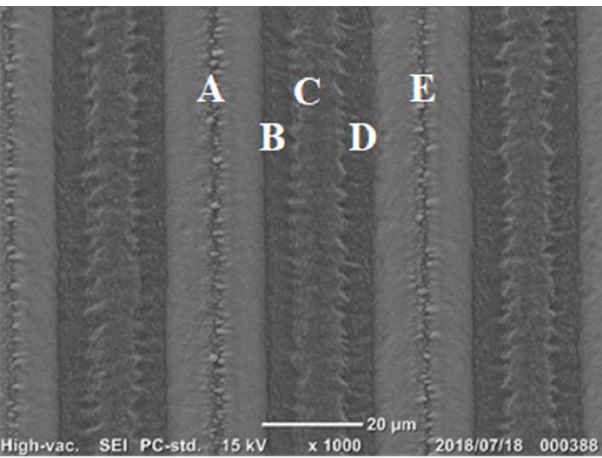
Figure 3. Uniaxially formed micro-/nano-textures onto the AISI304 surface by the femtosecond laser.